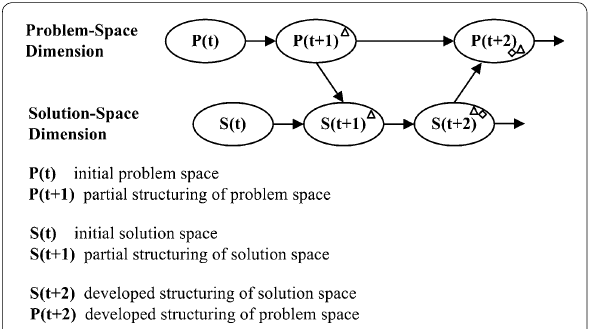
Figure 1 Dorst and Cross’s [26] problem-solution co-evolution